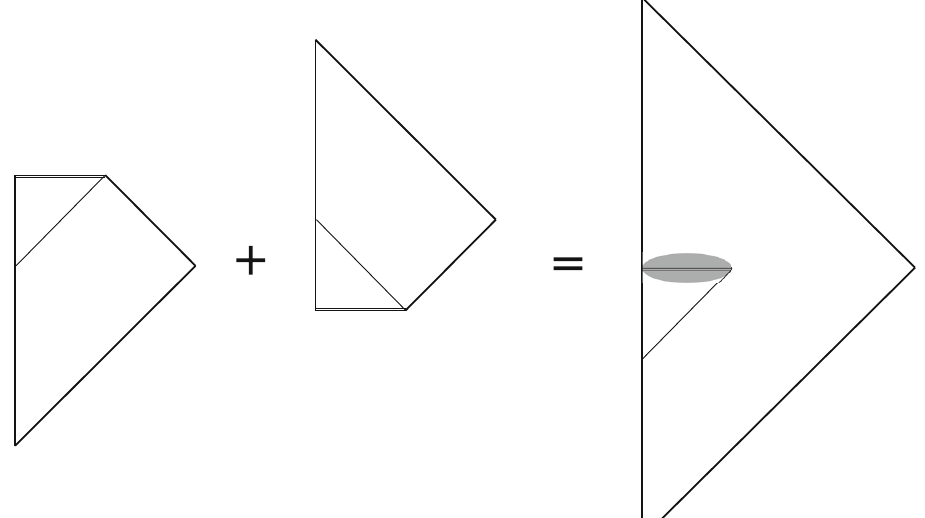
Fig. 5 Ashtekar–Bojowald model: The gray colored region is the place where quantum gravitational treatments